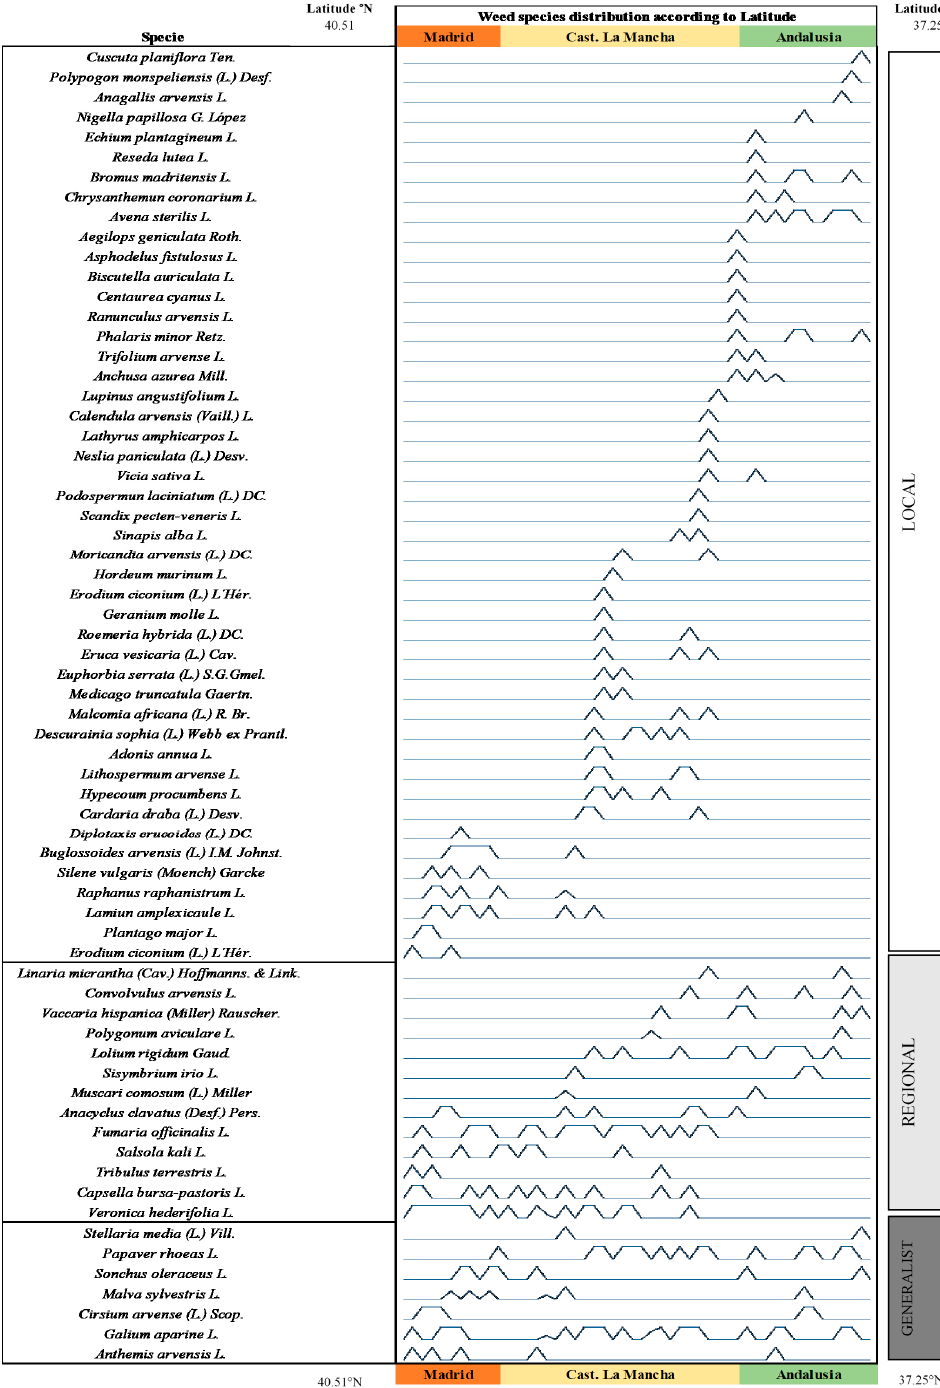
Figure 1. Graphical pattern of arable weed species distribution found in the studied areas according to latitude from Central to South of Spain (the peaks show presence of the weed species in the corresponding area).